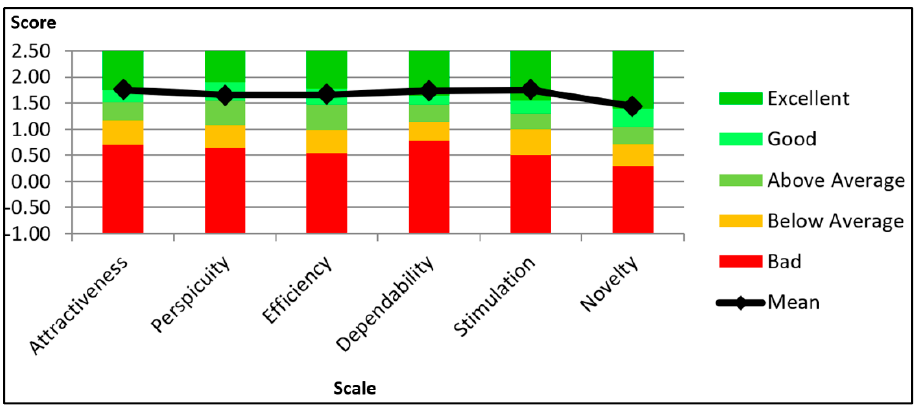
Figure 6. The UEQ results and